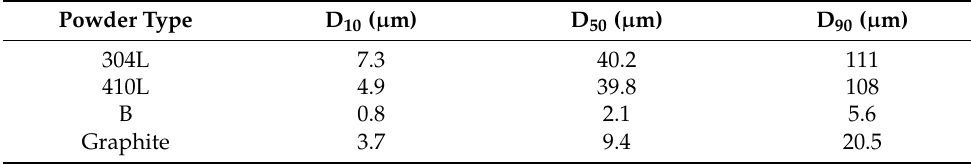
Table 1. The sizes of 304L, 410L, B, and graphite powders used in this study. Powder